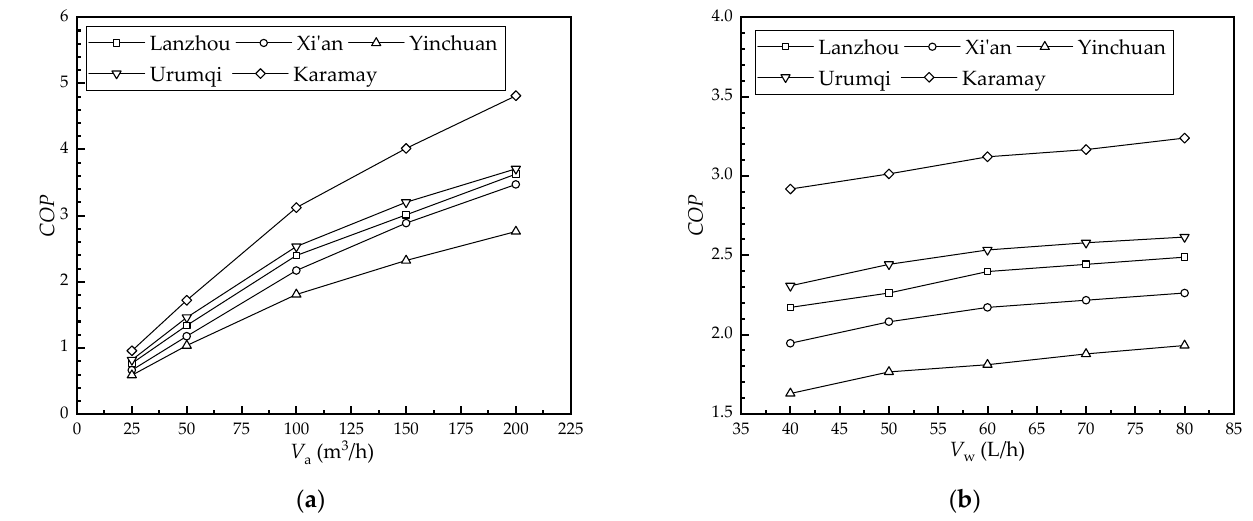
Figure 10. Effect of the flow rate on the COP in each city: ( a ) air flow rate; ( b ) water flow rate.